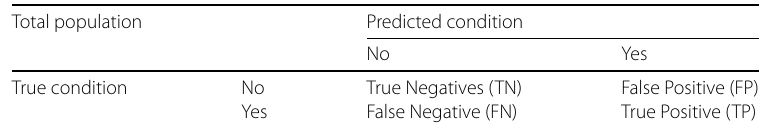
Table 4 Confusion matrix for the binary case Total population Predicted